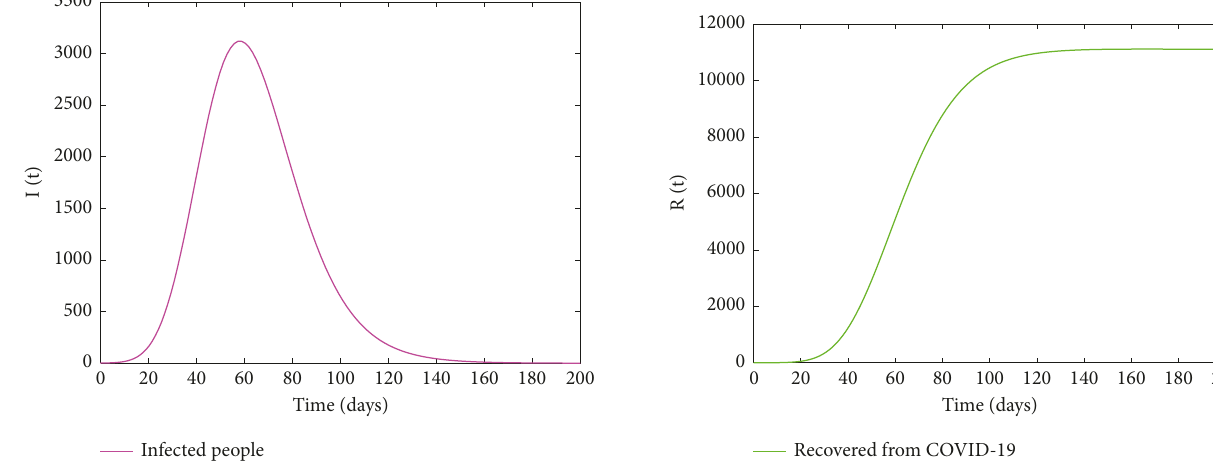
Figure 6: Behaviour of the COVID-19-infected individuals.